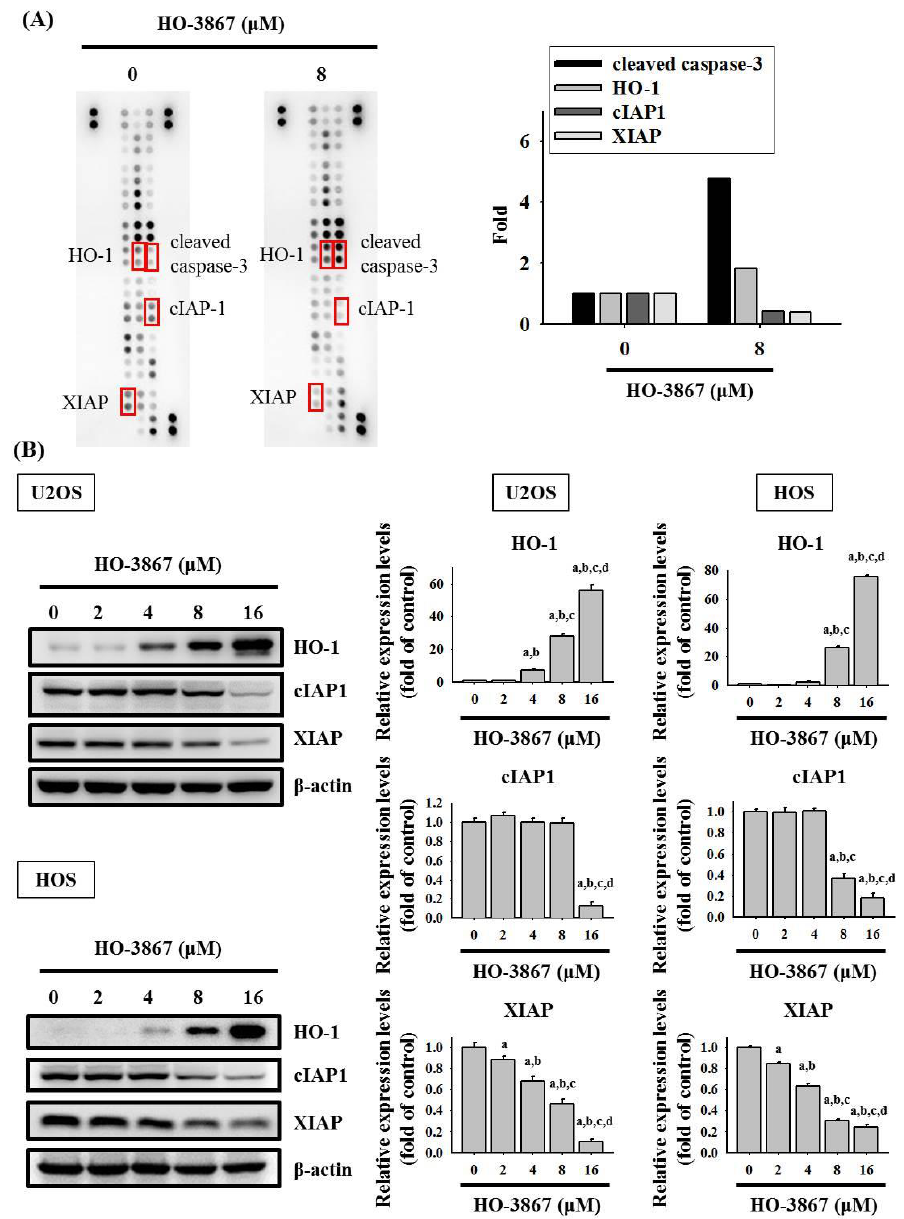
Figure 4. Analysis of the human apoptosis array and IAPs in HO-3867 treated U2OS cells. ( A ) After treatment with 8 µ M of HO-3867 for 24 h in U2OS cells, the human apoptosis array was employed. The increased proteins cleaved caspase-3 and HO-1 as well as the decreased proteins cIAP-1 and XIAP were subjected to quantitative analysis; ( B ) After experimental concentration range of HO-3867 treatment for 24 h, Western blot analysis was performed to measure expressions of HO-1, cIAP-1, and XIAP in U2OS and HOS cells. Then, quantitative analysis was assessed. n = 3. HO-1: U2OS: F = 601.182, p < 0.001; HOS: F = 3705.167, p < 0.001; cIAP-1: U2OS: F = 227.563, p < 0.001; HOS: F = 864.074, p < 0.001; XIAP: F = 227.563, p < 0.001; HOS: F = 864.074, p < 0.001. a Significantly different, p < 0.05, when compared to control. b Significantly different, p < 0.05, when compared to 2 µ M. c Significantly different, p < 0.05, when compared to 4 µ M. d Significantly different, p < 0.05, when compared to 8 µ